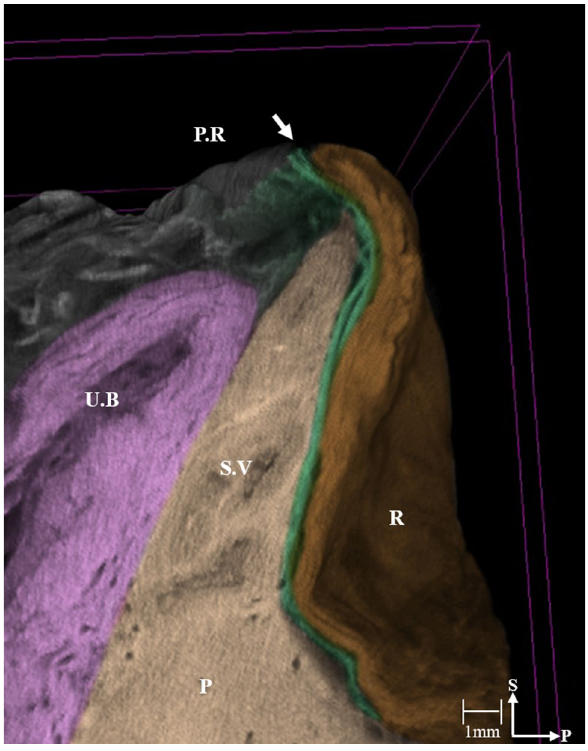
Figure 1. Three-dimensional anatomy of the hemi-pelvis reconstructed from micro-computed tomographic images. The arrow in in the micro-computed tomographic image indicates the deepest point of the rectovesical pouch where the DVF extends. (DVF; green). The 3D morphology of the DVF is also shown as a movie in Supplemental Video 1. PR, peritoneal reflection; UB, urinary bladder; SV, seminal vesicle; P, prostate; R, rectum; S, sagittal; P,